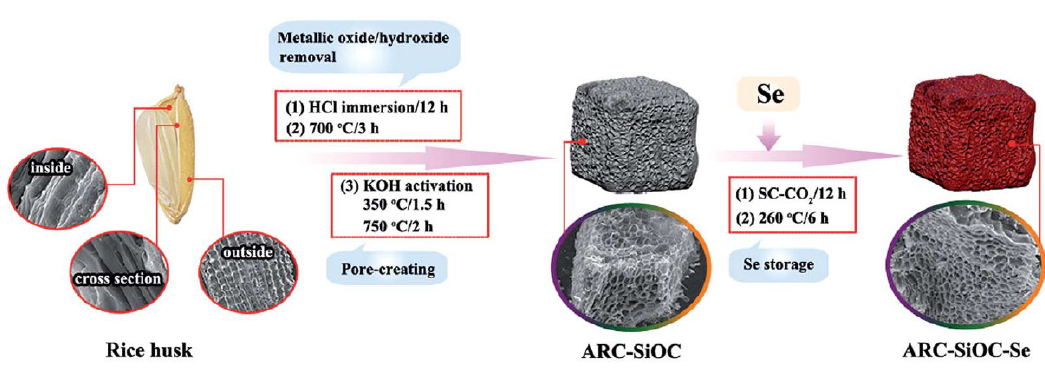
Fig. 25 Schematic of the synthesis of 3D porous SiOC/Se composite (ARC–SiOC = active rice husk carbon–SiOC matrix). Reproduced with permission from Ref. [491], © The Royal Society of Chemistry